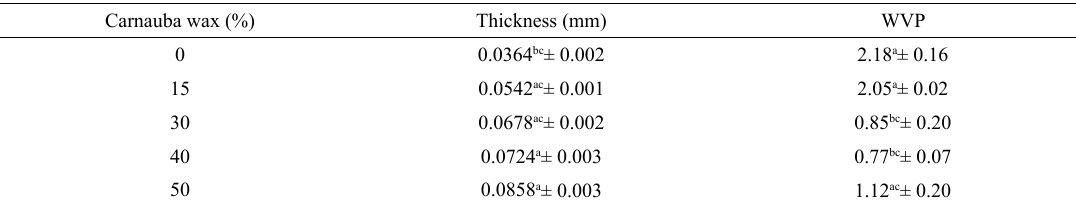
Different lowercase letters in superscript mark significantly different mean values within the same column.